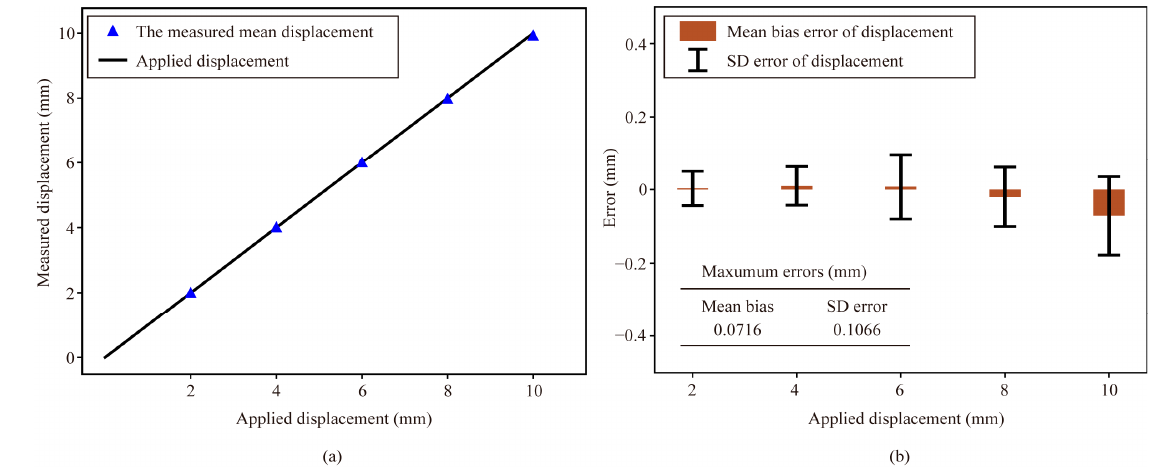
Figure 7. Displacement measurement results. ( a ) Mean displacement for translation tests versus the pre-applied displacements; ( b ) mean bias error and standard deviation error of the measured displacements.